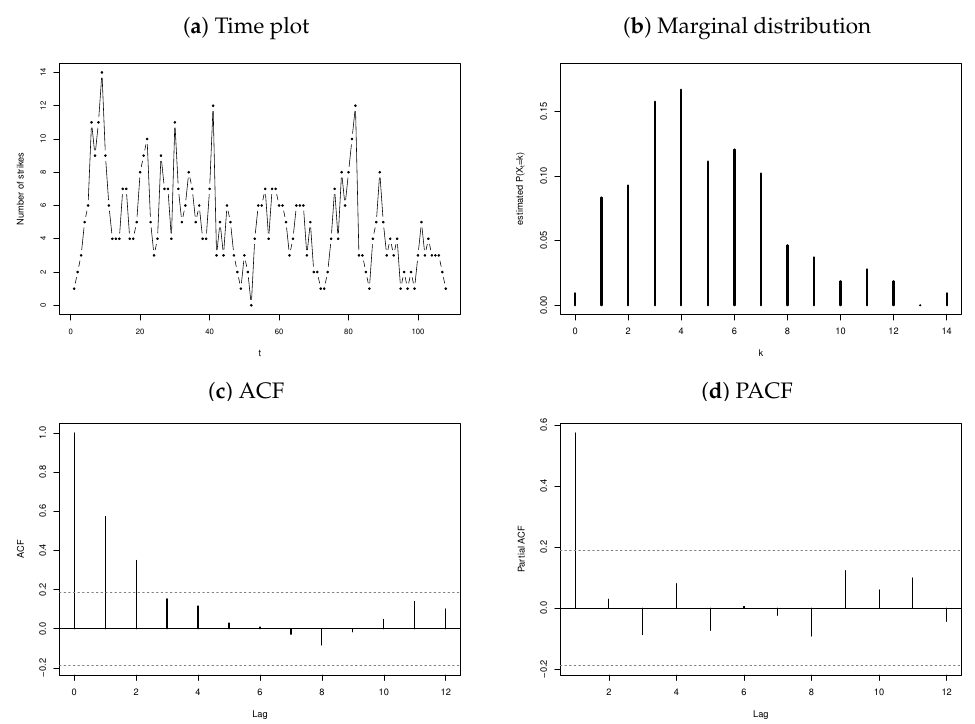
Figure 12. Time plot, observed marginal distribution, ACF, and PACF for the strike